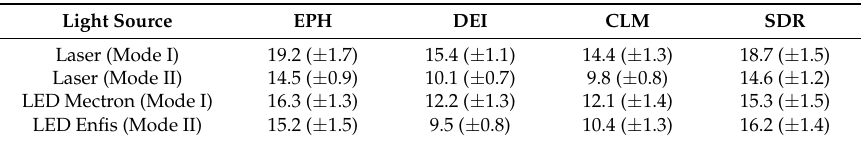
Table 3. Temperature rise ( ◦ C) recorded during the photopolymerisation process for the analysed materials, according to light source and curing mode. All the results are reported in terms of mean values and standard deviation (in